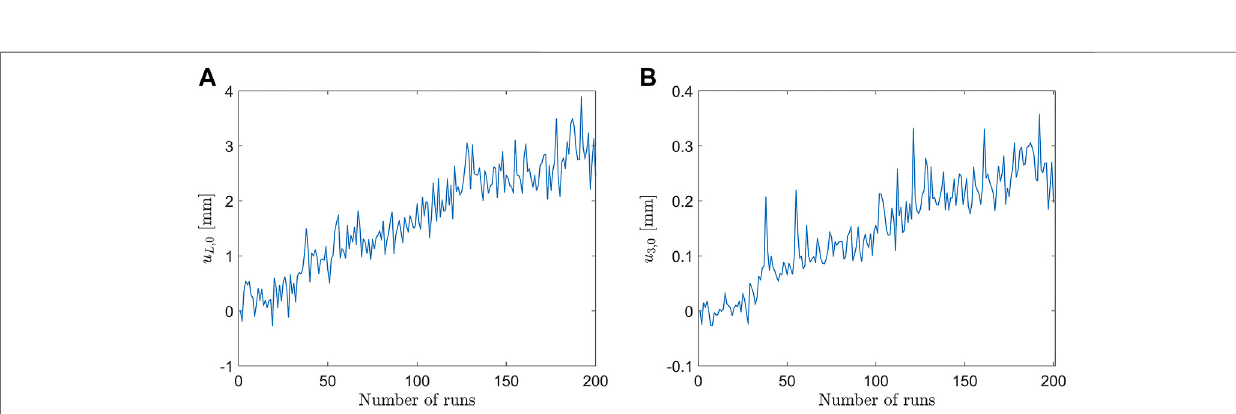
FIGURE 6 | Drift in the hybrid model response: (A) u L and (B) u 3 .